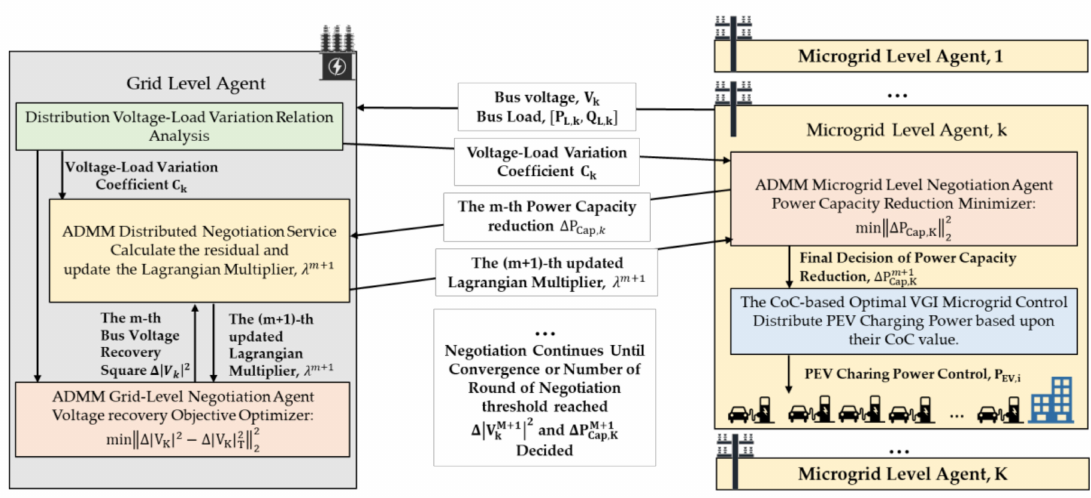
Figure 4. The development and message flow of the distributed voltage compensation negotiation and VGI microgrid control.